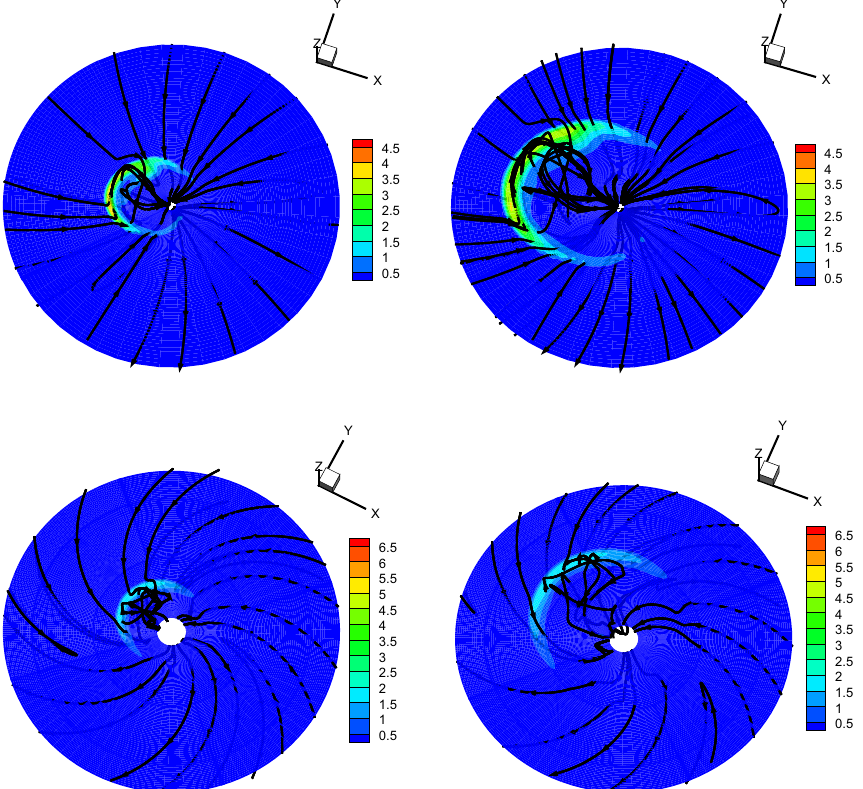
Fig. 10. The simulated pro fi les of the relative density in the x – y equatorial plane at 3 h (top left), 6 h (top right), 20 h (bottom left), 40 h (bottom right). Solid black lines display magnetic streamlines. The write circle in the fi rst row is the Sun, and in the bottom row represent 20 R s .